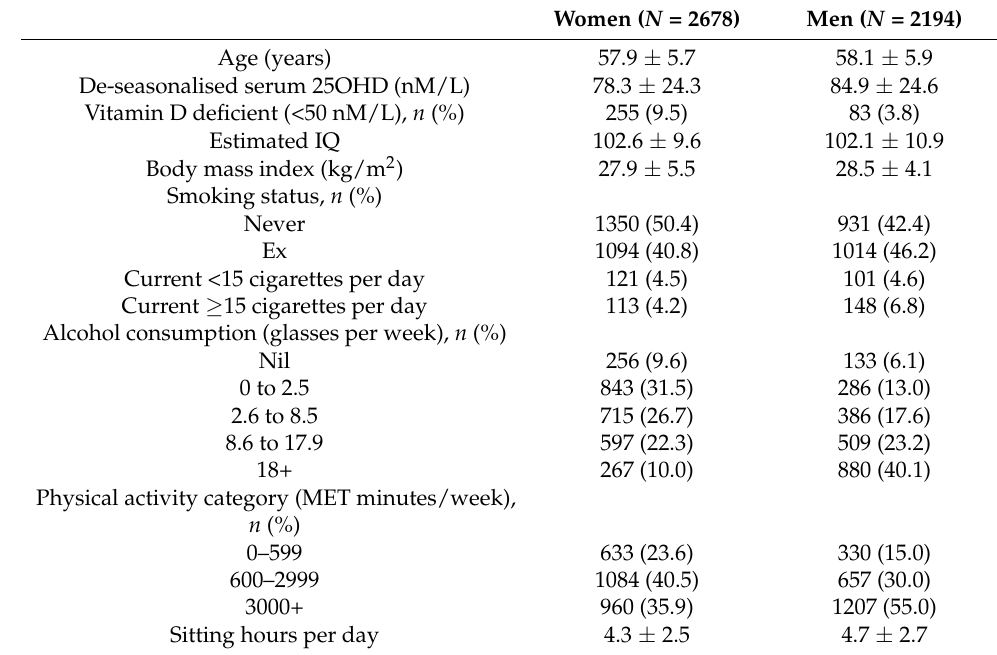
Table 1. Main characteristics and raw cognitive scores for the study